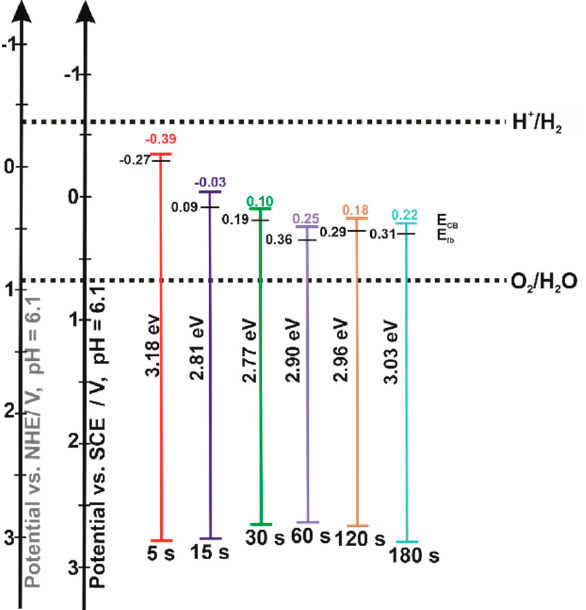
Figure 7. Energy positions of the conduction band (CB) and valence band (VB) of the studied Fe 2 O 3 –TiO 2 samples.